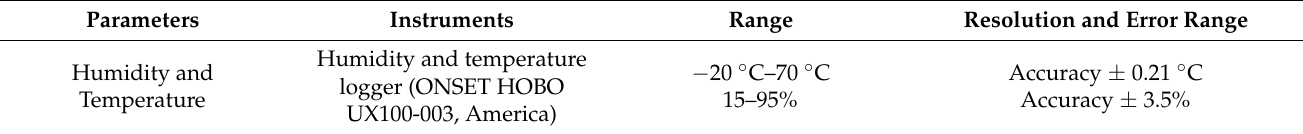
Table 3. Indoor environment parameters monitoring